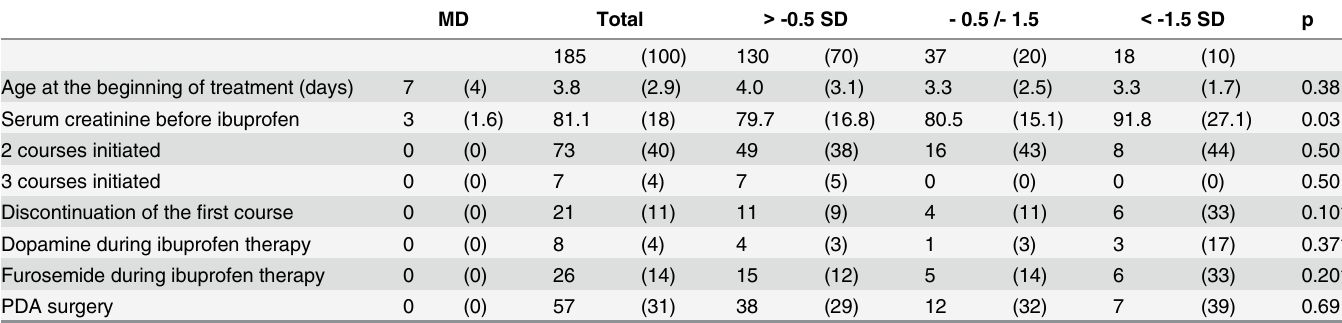
Table 2. Ibuprofen treatment